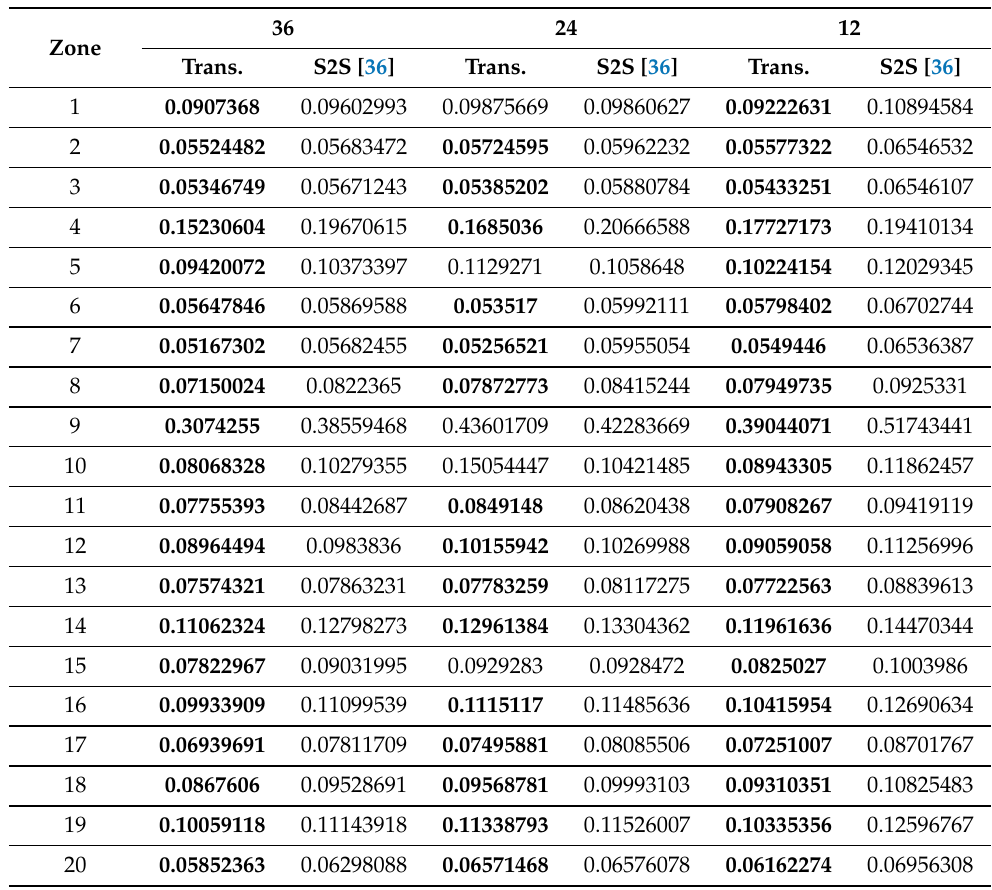
Table 5. Comparison of average MAPE for each stream over each input size. The bold numbers indicate where transformers outperform